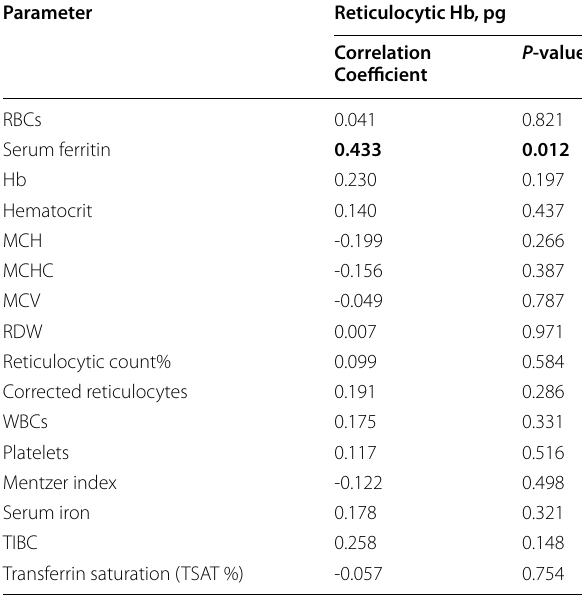
Table 4 Correlations between Reticulocytic Hb and certain studied parameters in the whole